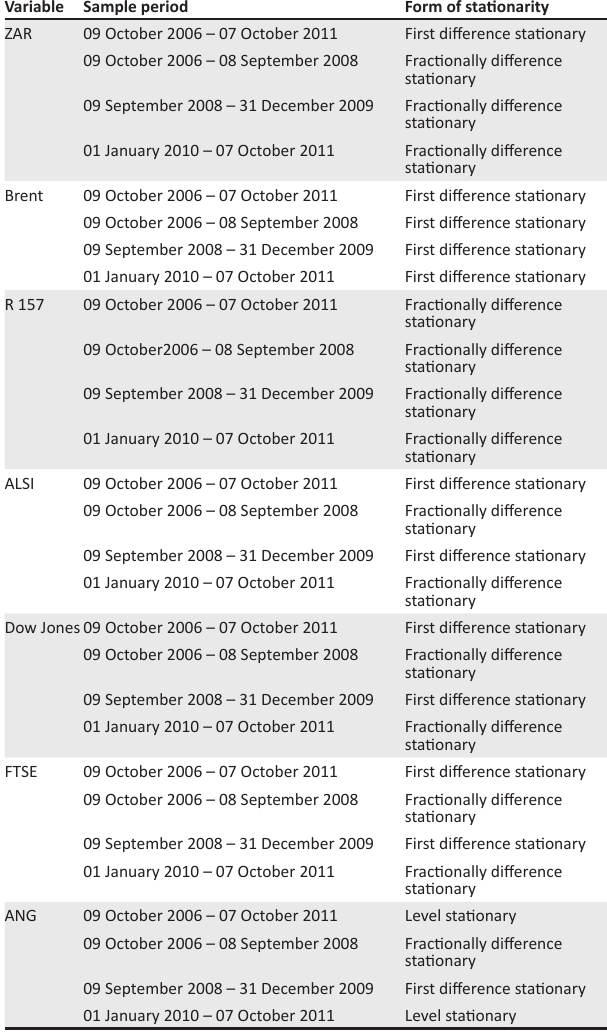
TABLE 1: Summary of the correct form of